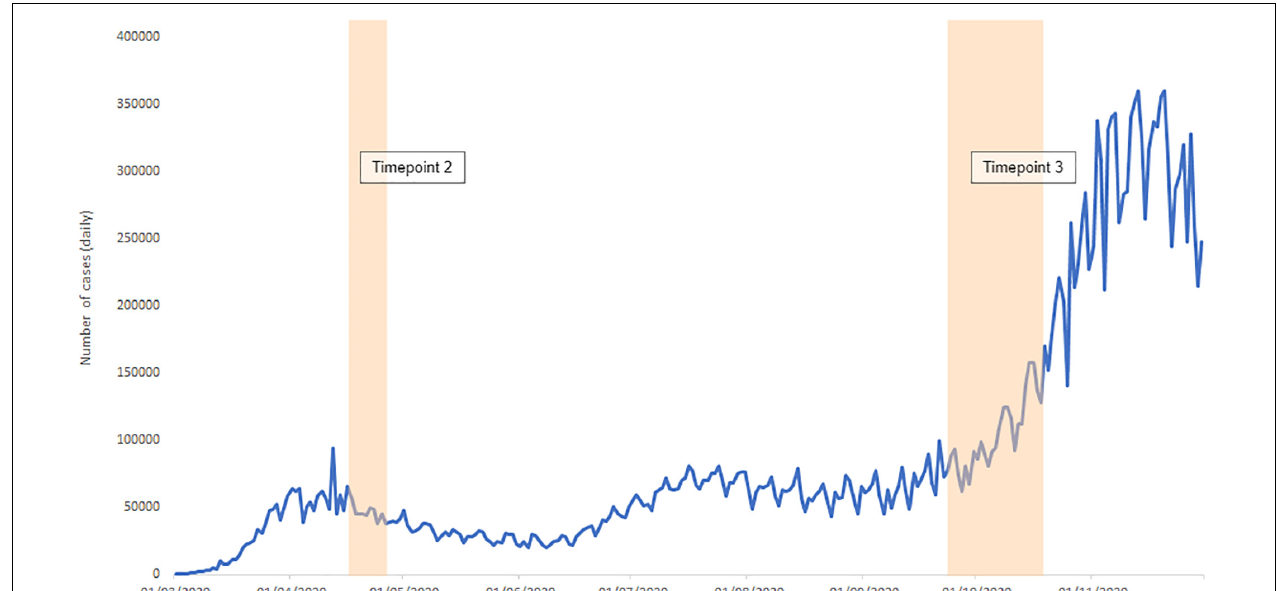
FIGURE 1 | Timeline showing data collection intervals during the pandemic in the context of daily case rate (sum across sample countries-of-residence). Vertical shaded blocks represent data collection periods in 17th–26th April 2020 (timepoint 2) and 25th September–19th October 2020 (timepoint 3). Note that at timepoint 2, national or localised lockdowns were in place in the United Kingdom (60.2% of sample) and the majority of other countries-of-residence sampled. Two participants were resident in Hungary where localised recommendations were in place rather than lockdowns. At timepoint 3, all countries sampled were not in national lockdowns. COVID-19 data taken from COVID-19 Data Repository by the Center for Systems Science and Engineering (CSSE) at Johns Hopkins University. Cases are daily new confirmed cases of COVID-19 summed across the countries-of-residence sampled.